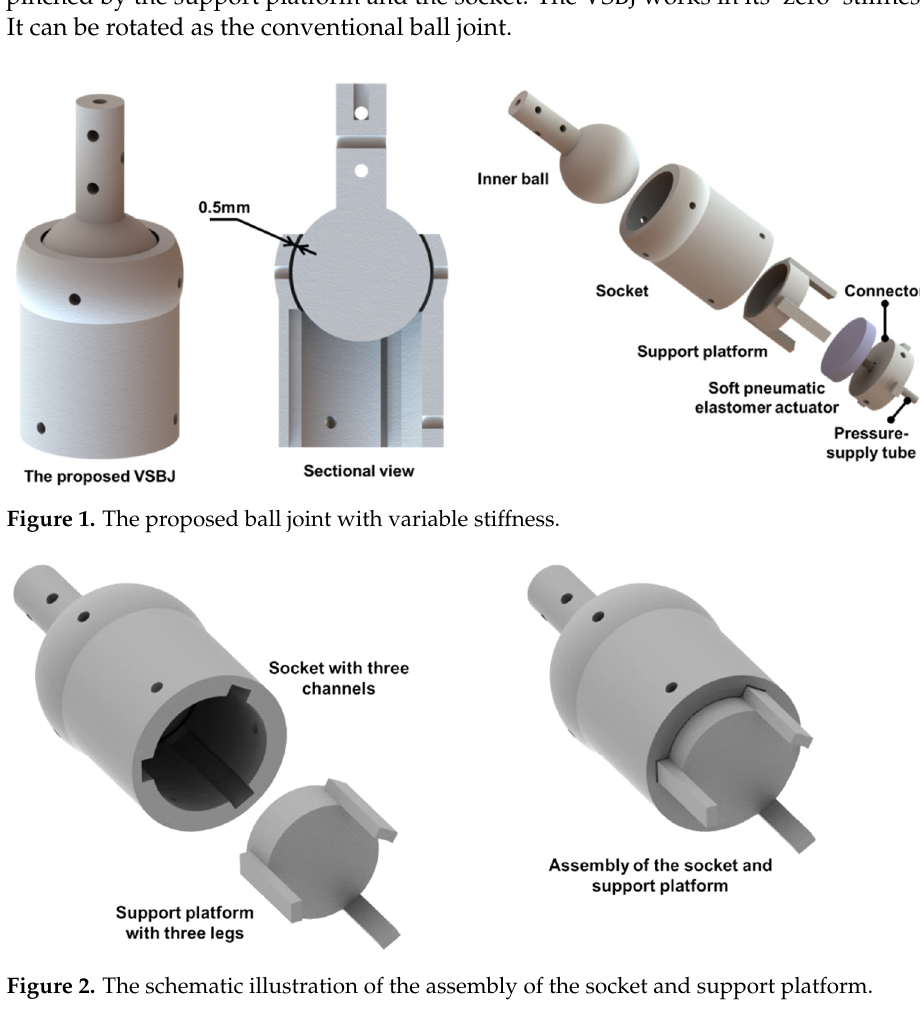
Figure 2. The schematic illustration of the assembly of the socket and support platform.